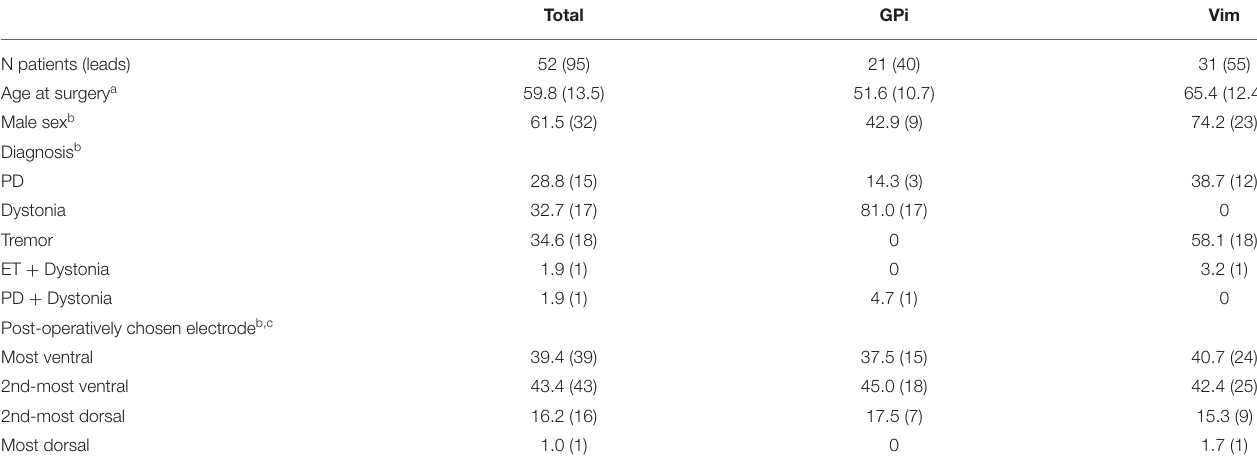
TABLE 1 | Patient characteristics.